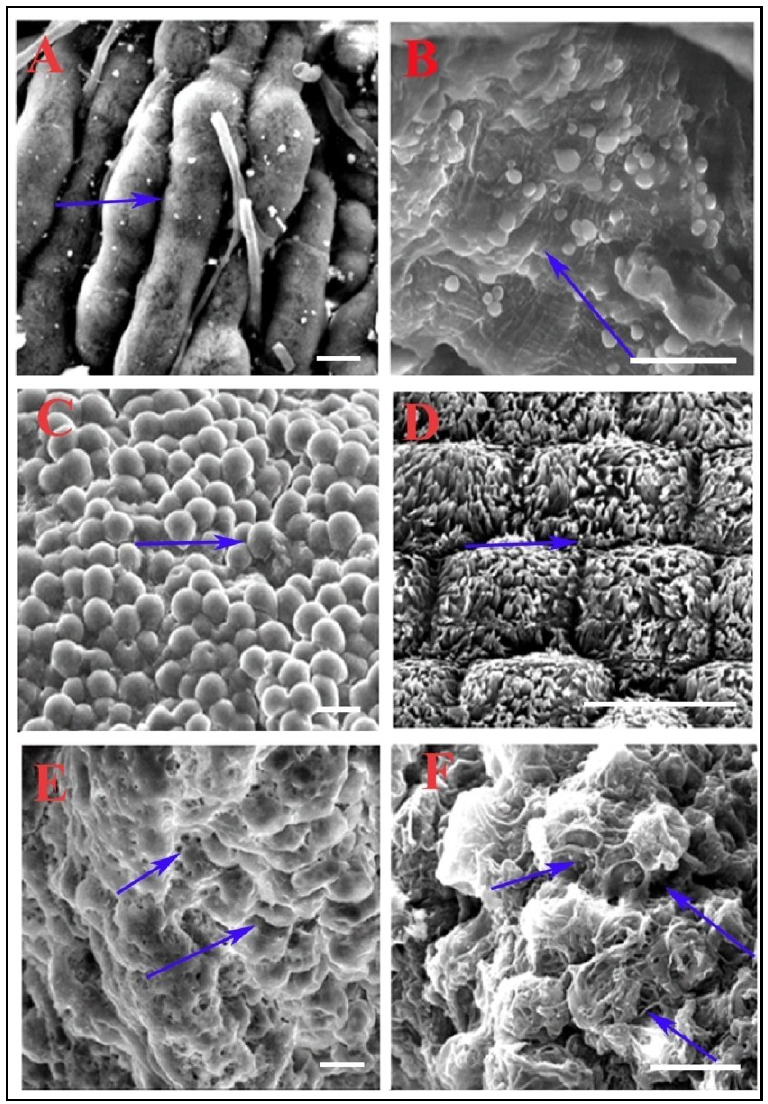
Figure 3. Scanning electron microscopic analysis showing morphological abnormality in CEA supplemented diet fed insect midgut epithelial cells of RCB. ( A , B ) showing the normal midgut morphology of well-fed insect gut; ( C , D ) showing the morphology of starved insect midgut; ( E , F ) showing the abnormal morphology of lectin supplemented diet fed insect midgut. (Bar- 800×